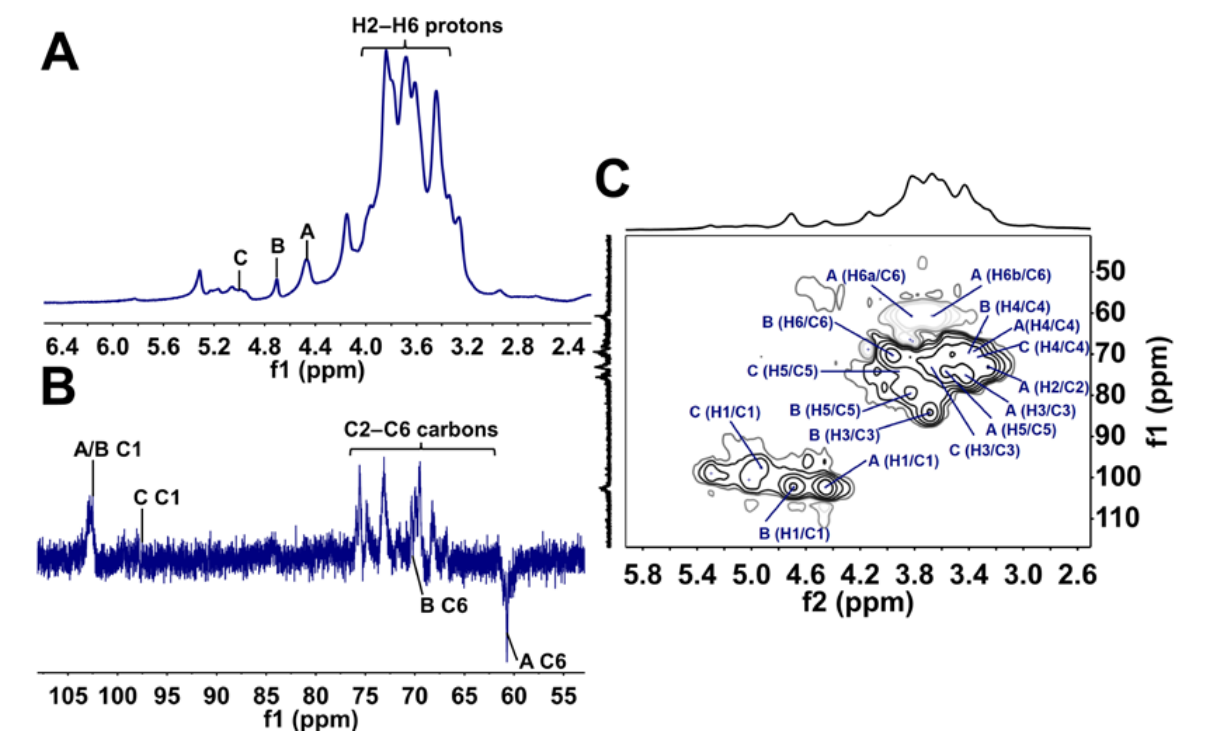
Figure 3. 1 H NMR ( A ), DEPT-135 ( B ) and 1 H- 13 C HSQC ( C ) spectra of GACP. A, B and C refer to the residues found in the structure of GACP. A: β -D-Glcp-(1 → ; B: → 3)- β -D-Glcp-(1 → and C: α -D-Glcp-(1 → . Table 2. 13 C and 1 H NMR chemical shifts of GACP.